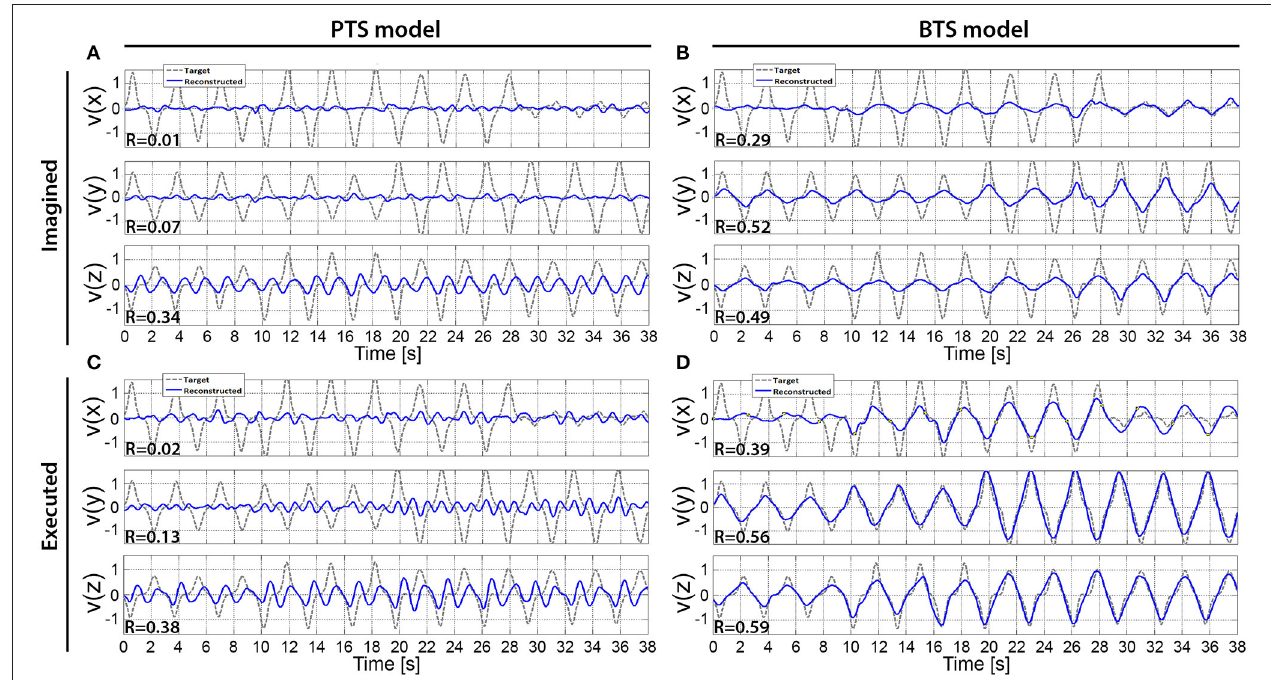
FIGURE 10 | The cross-subject average of reconstructed hand velocity vector components. V(x), v(y), and v(z) velocity vector components are matching with executed or imagined movement in horizontal, vertical, and depth directions, respectively. For the imagined movement reconstruction (A,B) , the target trajectory was calculated based on arm movement trials. The averaged trial of the imagined arm movement velocity reconstruction is presented in (A,B) for the PTS and BTS models, respectively. The averaged trial of executed arm movement velocity reconstruction is presented in (C,D) for the PTS and BTS models, respectively. The averaged trial for the PTS model ( A,C ) involve results of time-series predictions using the time-resolved low delta (0–2Hz) band-pass filtered EEG. The averaged trial for the BTS model (B,D) involve results of time-series predictions using PSD of the optimal band selected in the inner level cross-validation [i.e., mu (8–12Hz), lower beta (12–18Hz), upper beta (18–28Hz), and gamma (28–40Hz)